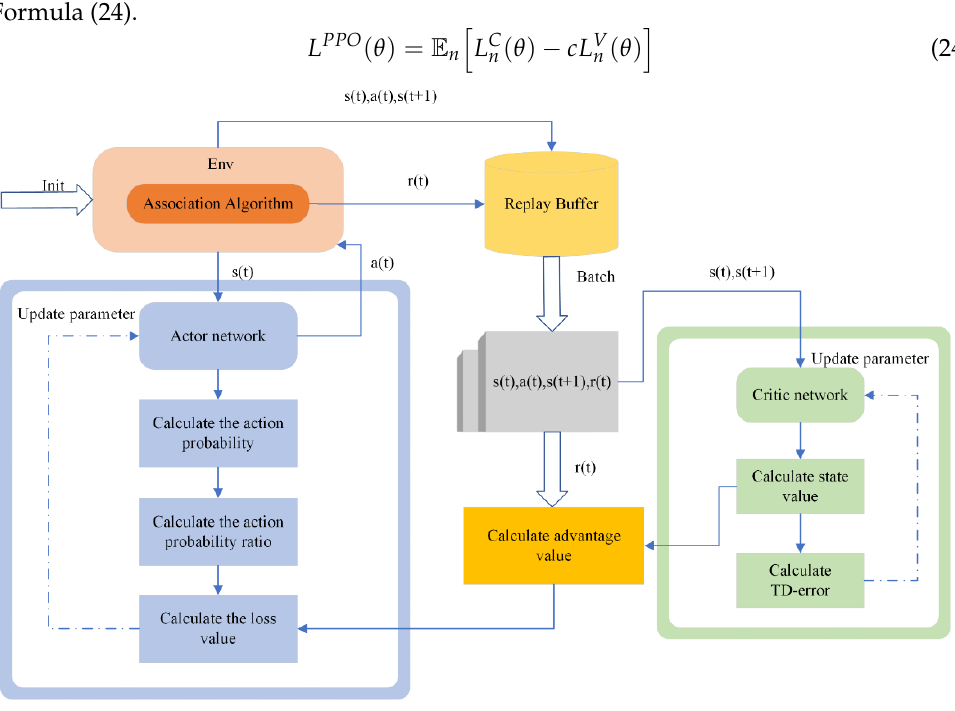
Figure 2. The structure of DCMCE algorithm.